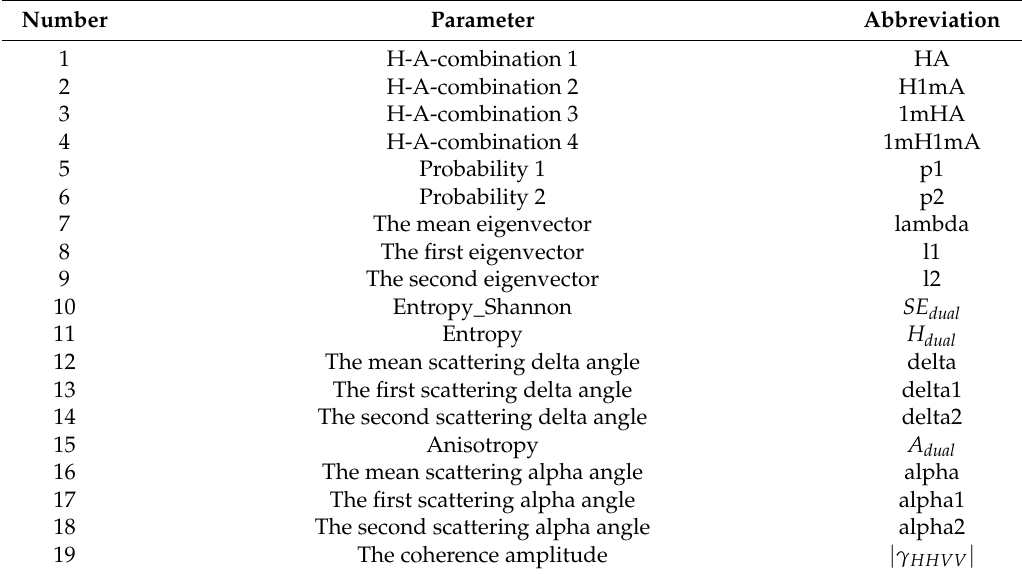
Table 2. Overview of the 26 parameters derived from the dual-polarimetric TerraSAR-X and RADARSAT-2